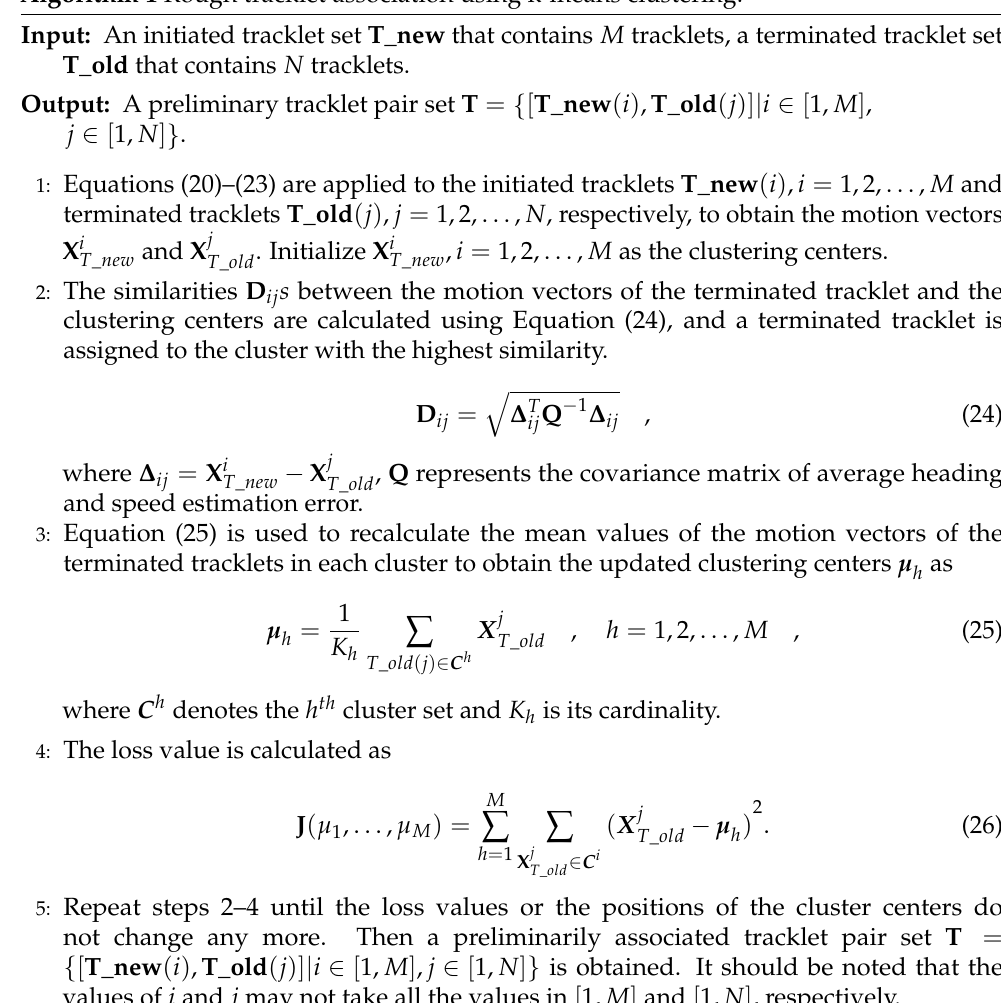
Algorithm 1 Rough tracklet association using k-means